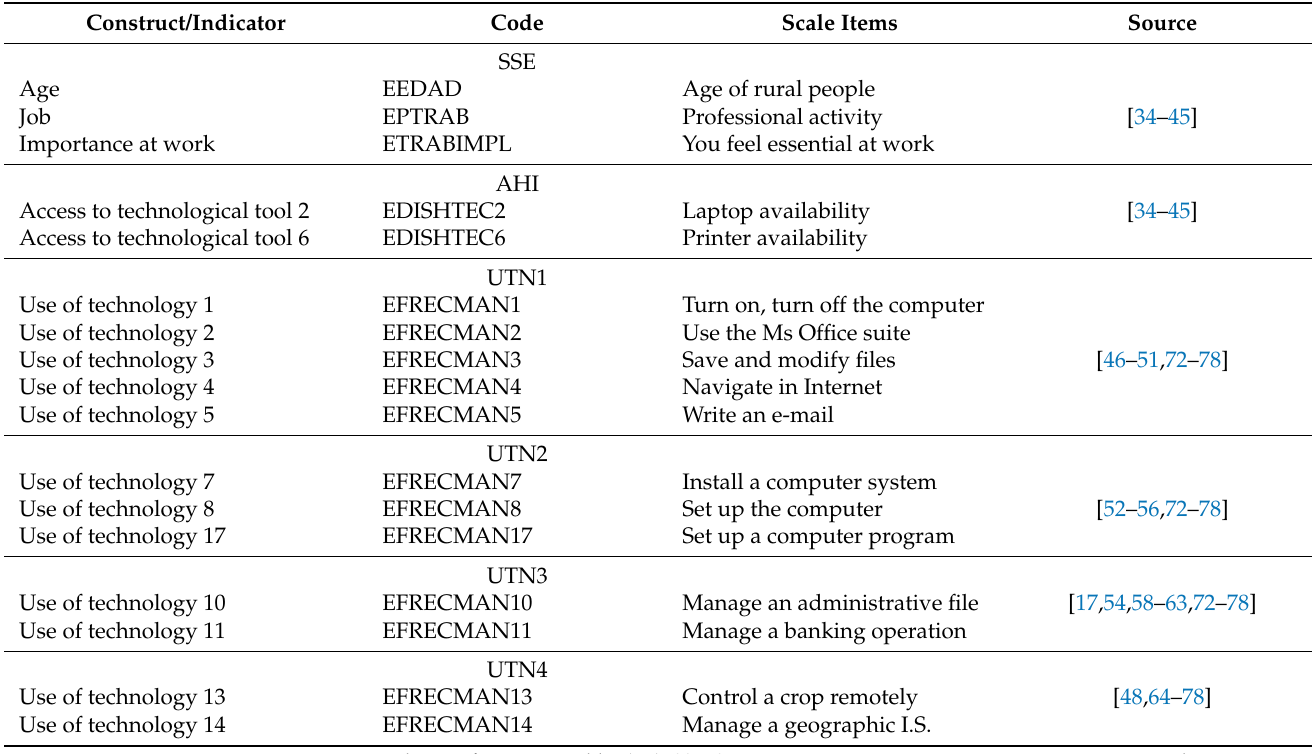
Table 1. Constructs and scale í